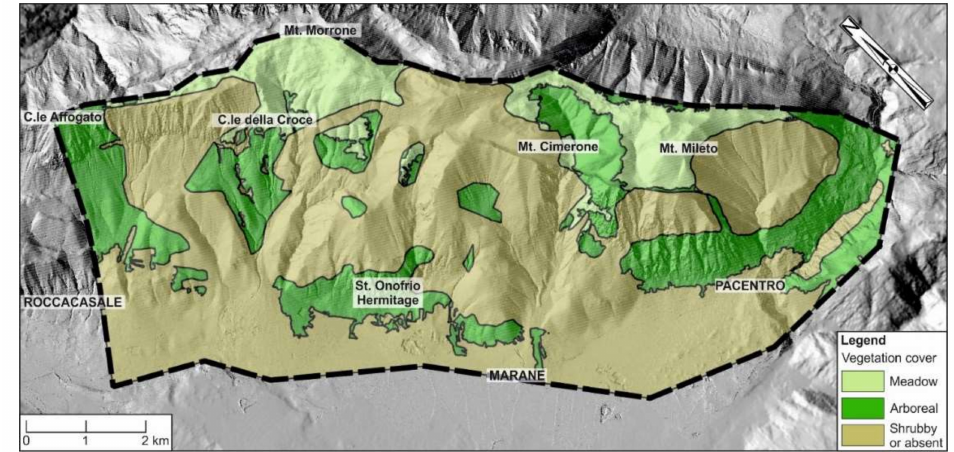
Figure 6. Post-wildfire vegetation cover map. The black dashed box indicates the location of the study